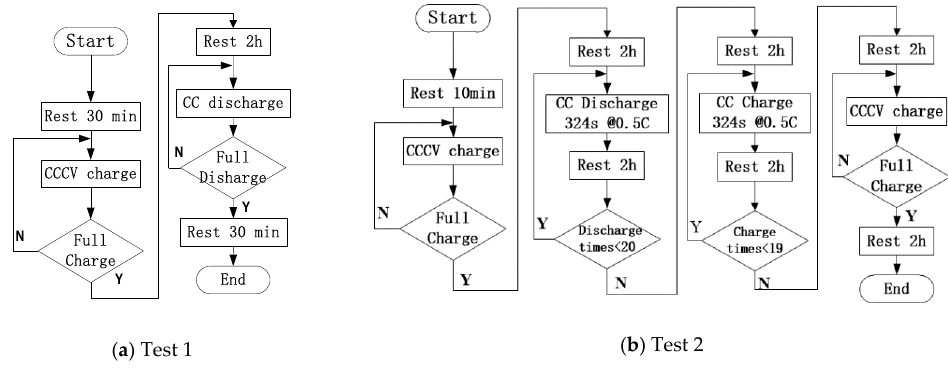
Figure 2 . Flowchart of the procedure. Figure 2. Flowchart of the procedure.